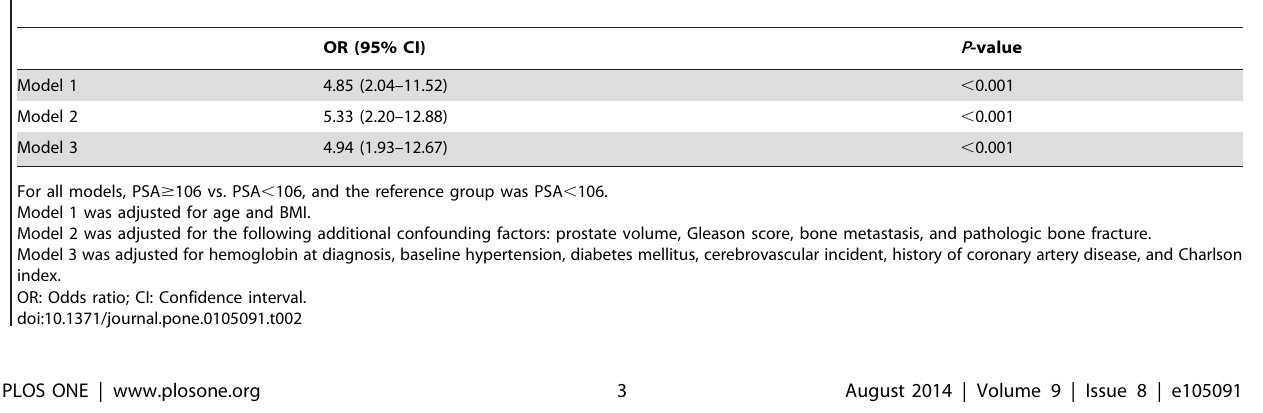
Table 2. BCP in high and low initial PSA